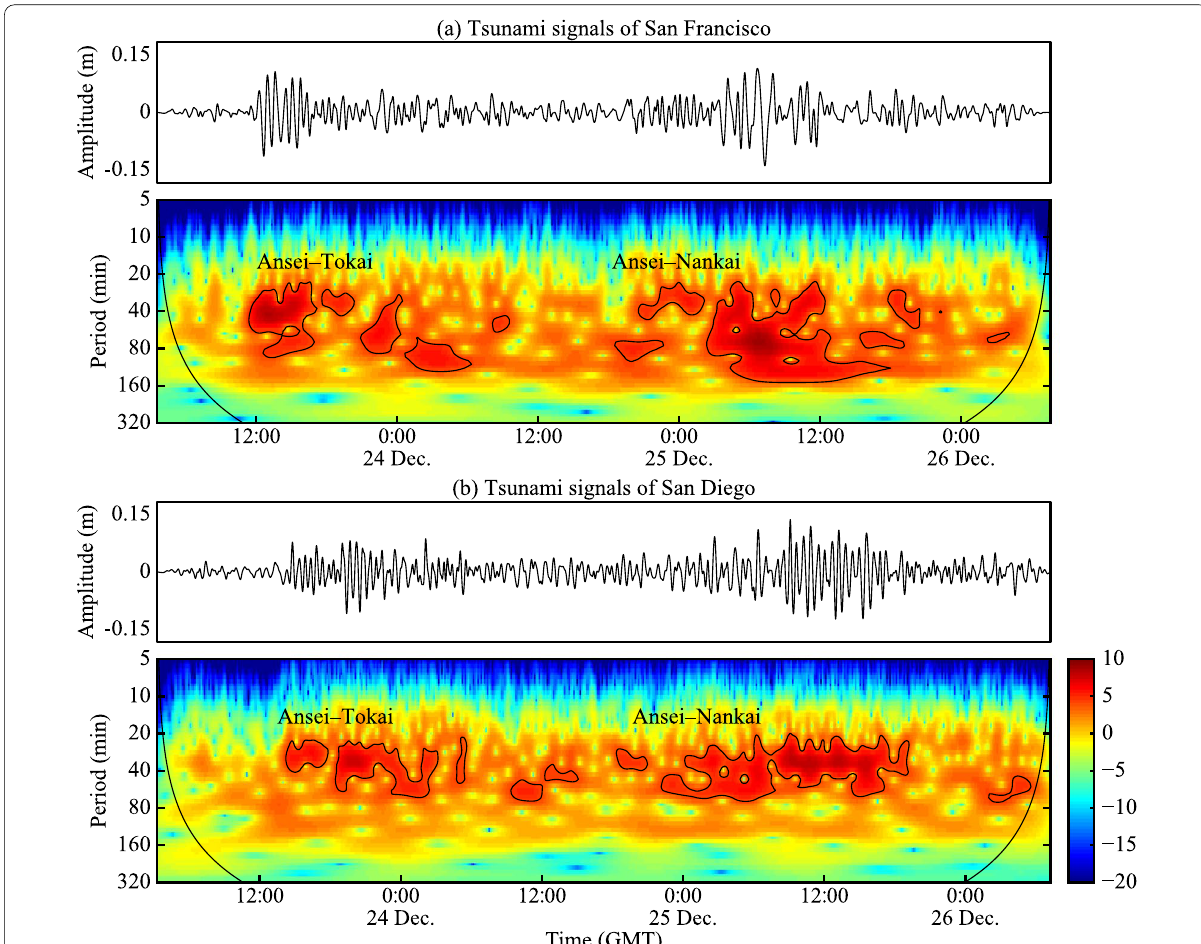
Fig. 5 Wavelet analysis results for the tsunami signals recorded at the a San Francisco and b San Diego tide gauge stations. The amplitudes have not been normalized. Contour lines show the 95% confidence